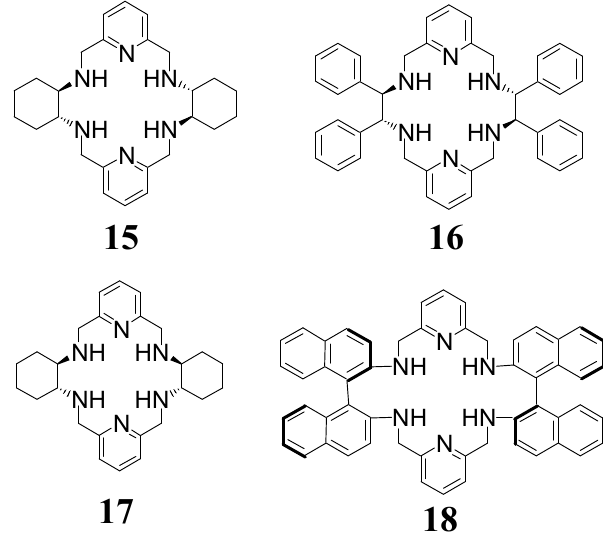
Figure 8. [2 + 2] amines derived from 2,6-diformylpyridine.